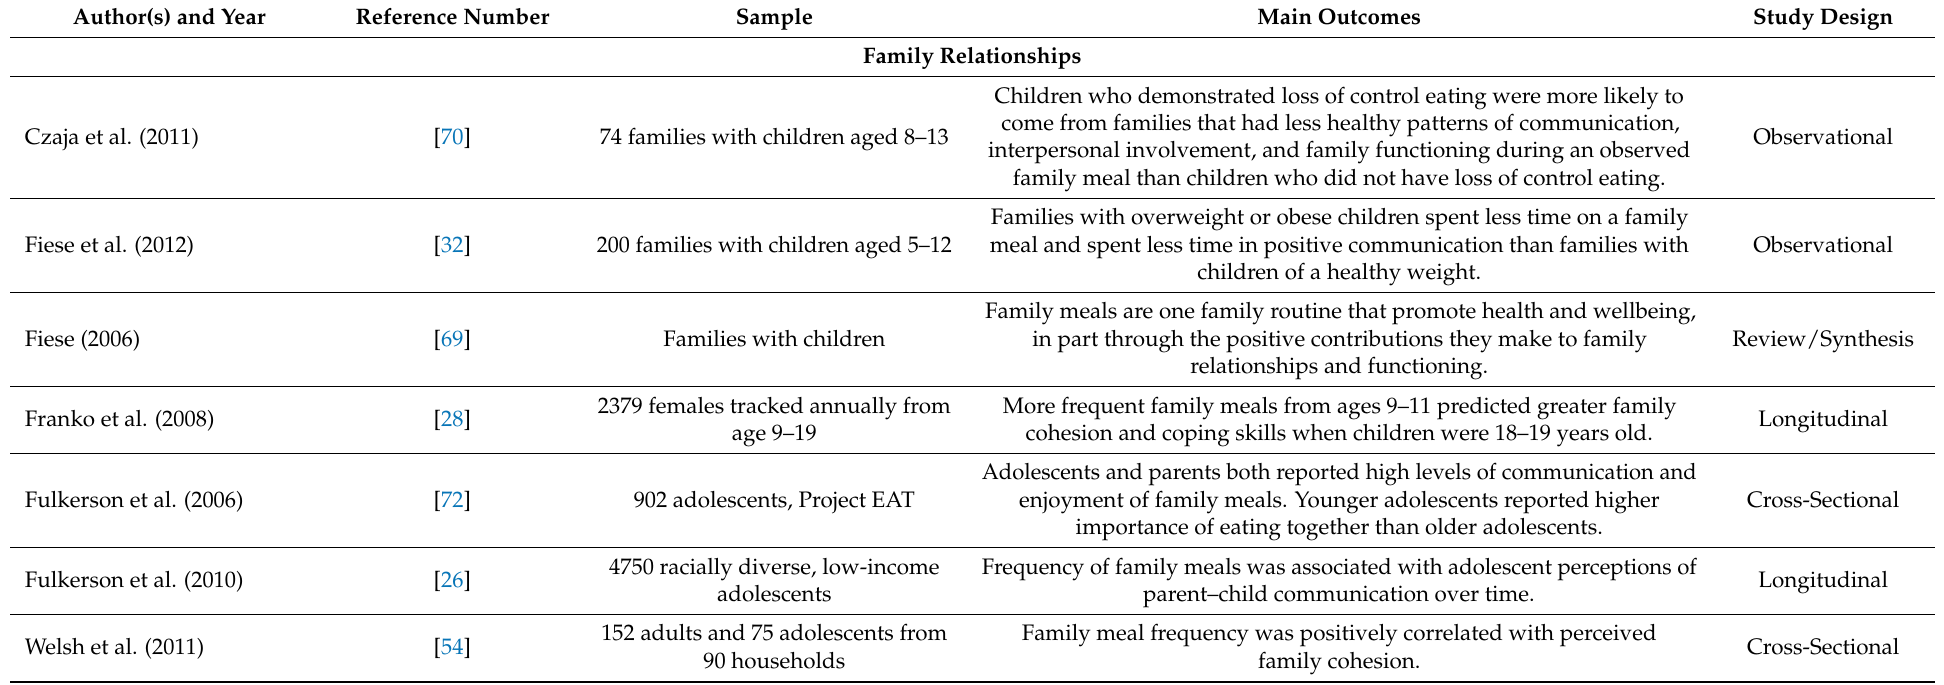
Table 4. Summary of Family